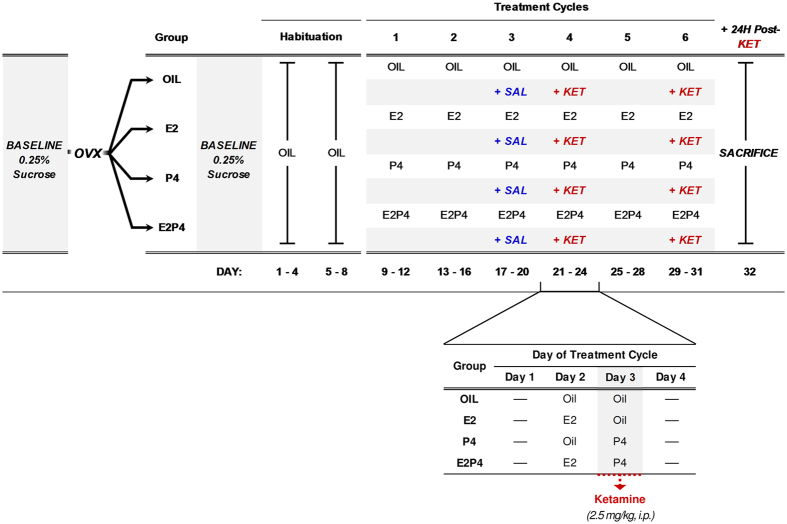
Timeline of procedures and cyclic hormone treatment regimen for Experiment 1.Abbreviations: E2, 17β-estradiol benzoate; KET, ketamine (2.5 mg/kg); OIL, sesame oil; OVX, ovariectomy; P4, progesterone; SAL, saline.